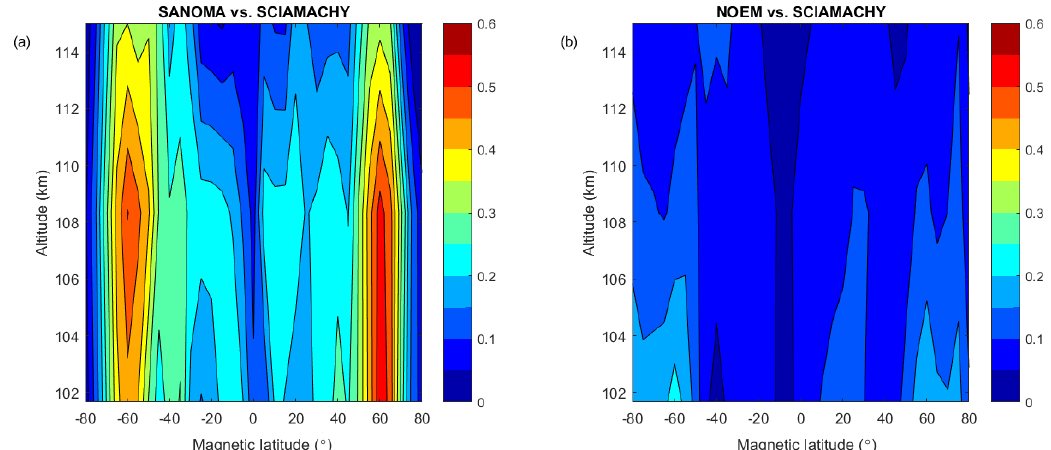
Figure 18. (a) Adjusted R 2 of a linear fit between SANOMA and SCIAMACHY NO number density. (b) Adjusted R 2 of a linear fit between NOEM and SCIAMACHY NO number